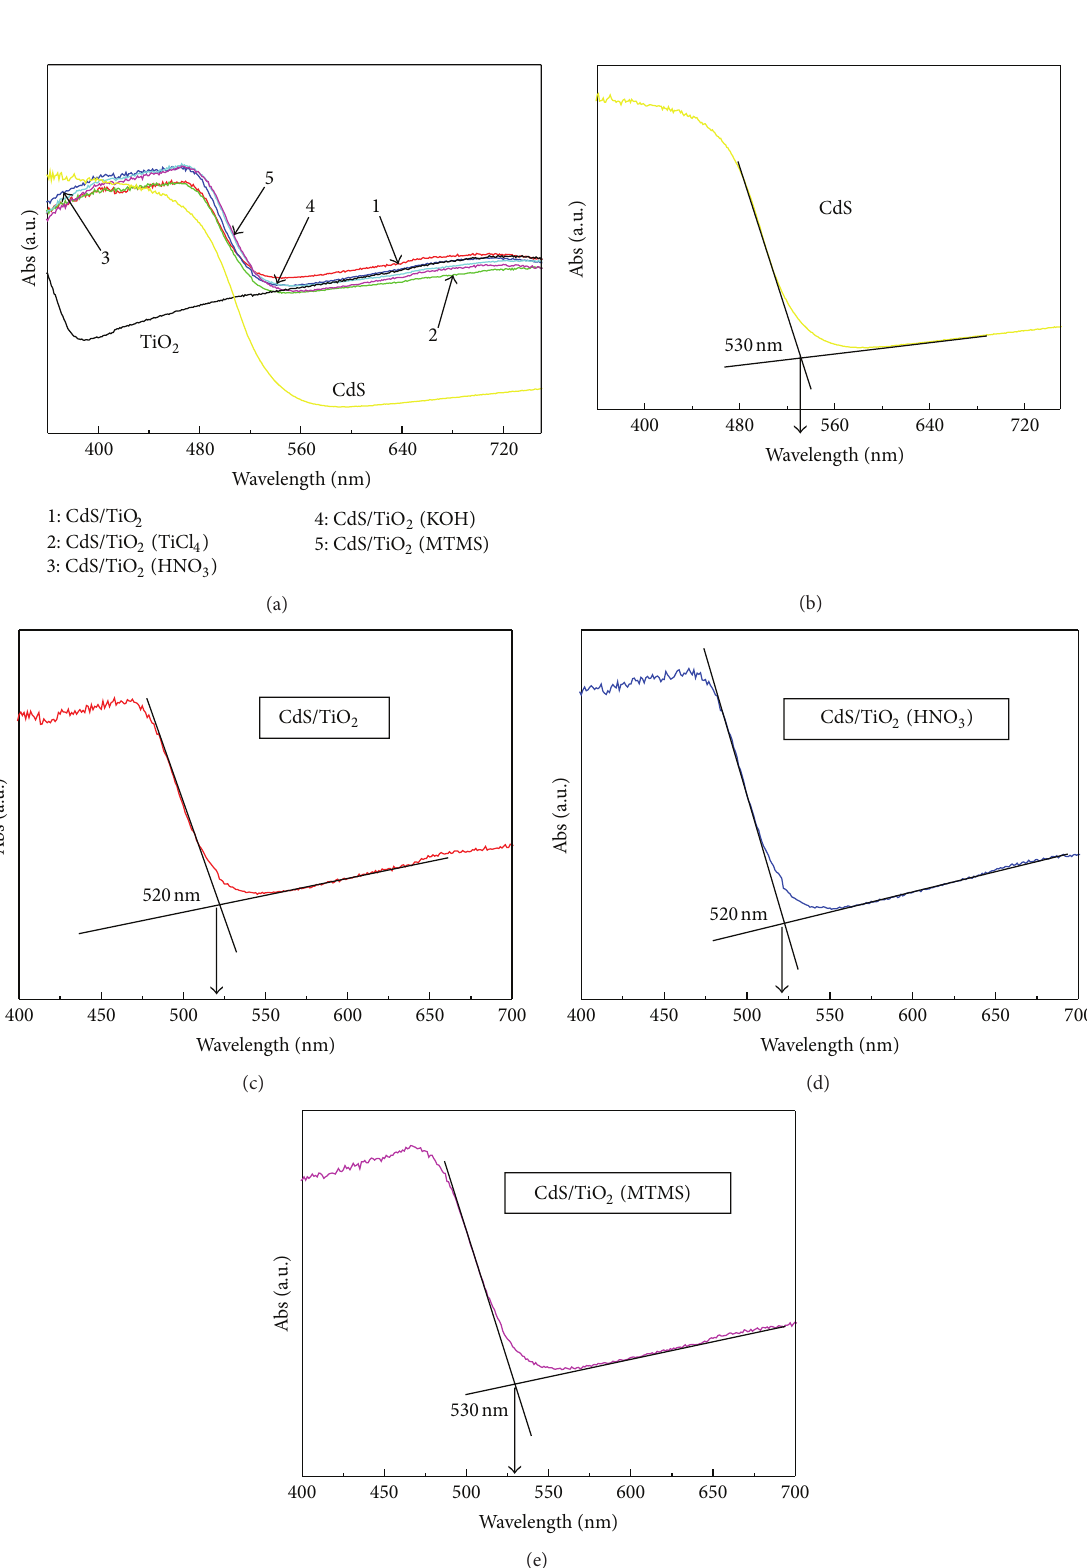
Figure 5: (a) UV-vis absorption spectra of TiO 2 nanotube arrays and CdS/TNAs with different modifications. Linear extrapolation is conducted to get absorption edges of (b) CdS particles, (c) CdS/TiO 2 , and (d) CdS/TiO 2 treated with HNO 3 and (e) CdS/TiO 2 treated with